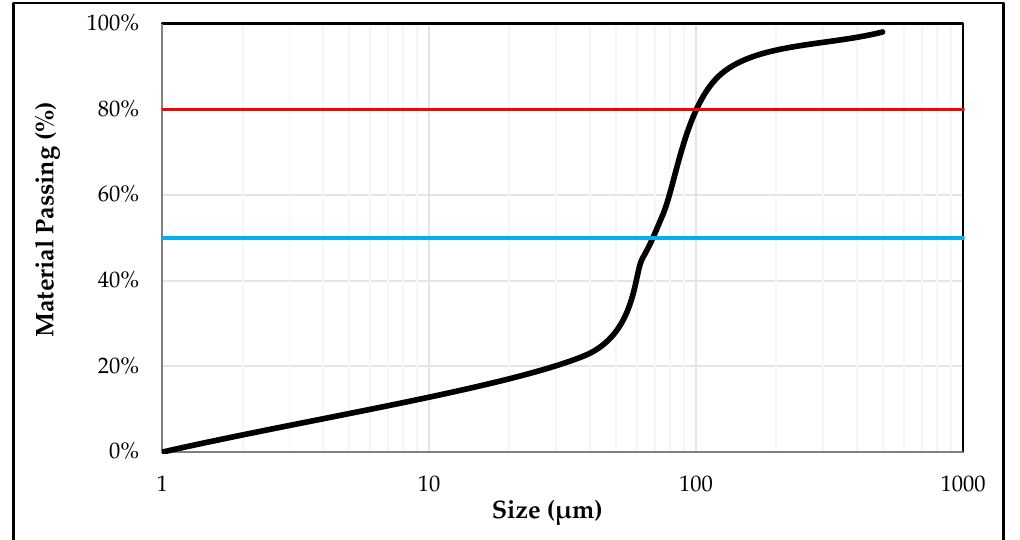
Figure 1. Grain size analysis of the as-received tailings.